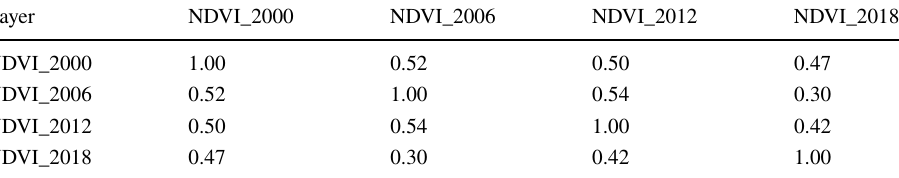
of NDVI raster calculations from 2000 to 2018 using the correlation matrix